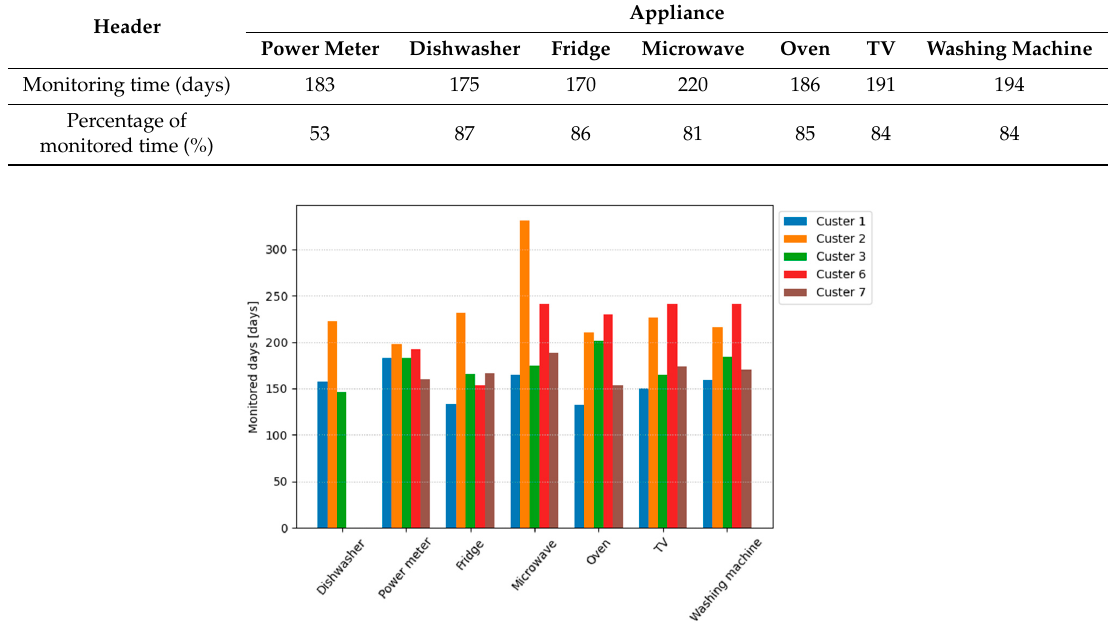
Figure 6. Average monitoring time by appliance and by cluster.